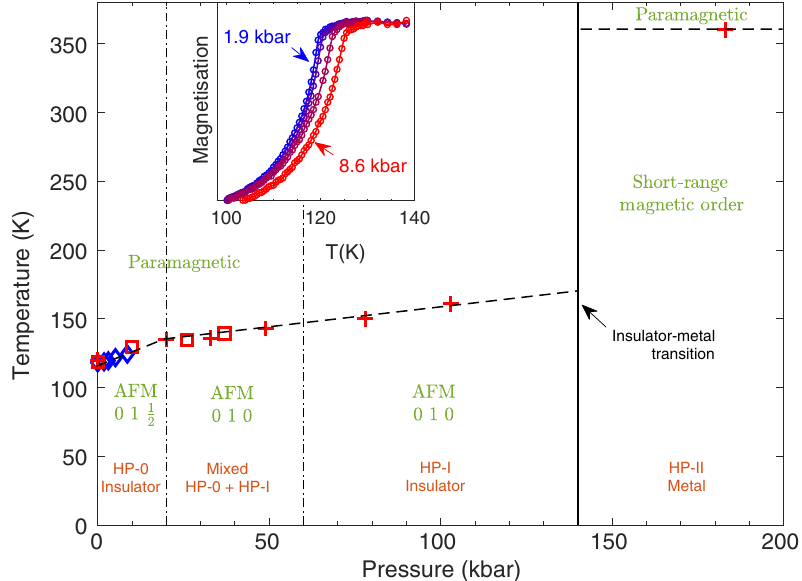
FIG. 2. Pressure-temperature phase diagram for FePS 3 constructed from data found in this work and the structural results from Ref. [35]. Data points display extracted temperatures of magnetic transitions plotted against pressure. Blue circles show values extracted from magnetization measurements, and red crosses and squares from integrating the magnetic peaks and features in the neutron powder patterns from the ILL and JINR data, respectively. Dashed lines delineating the AFM state are fits to the data points; gradients are stated in the text. Vertical lines on the phase diagram designate the pressures at which structural transitions occur. The inset shows normalized magnetization data plotted against temperature for increasing